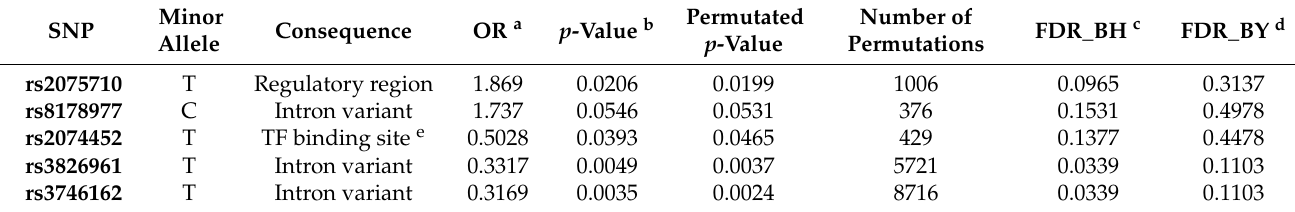
Table 2. GPX4 variants associated with POAF